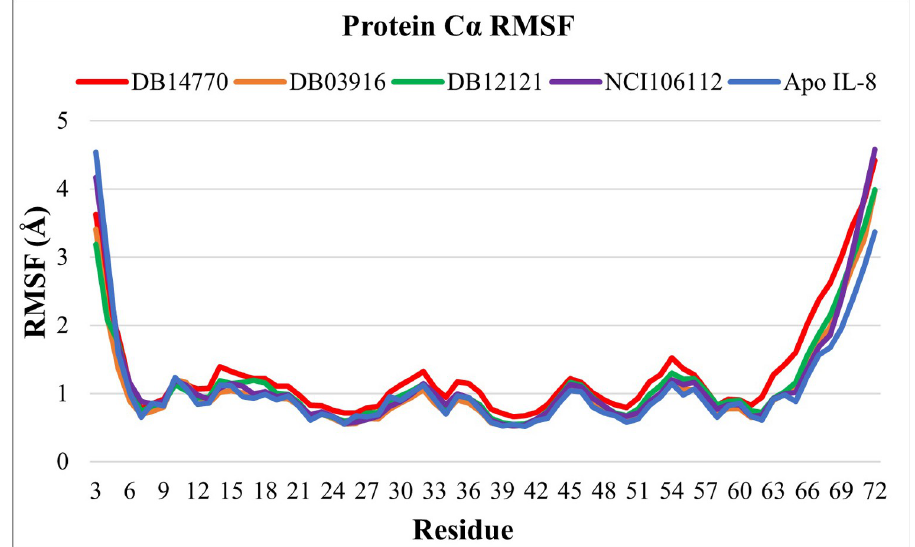
Fig 7. C-alpha RMSF analysis for IL-8 in apo and holo states.